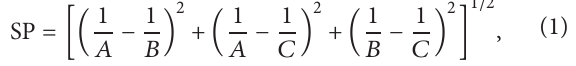
), , replacing energy ( coh 𝐸𝐸 Δ𝐸𝐸